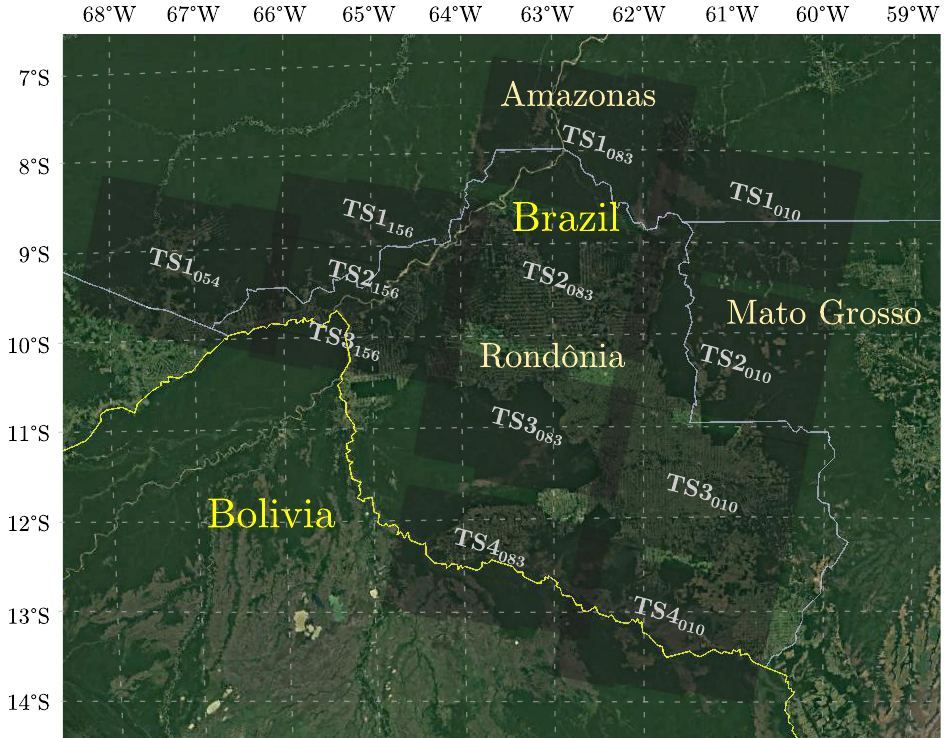
Figure 1. Study sites in the Amazon Forest comprising the Brazilian states of Rondônia, Amazonas, and Mato Grosso, as well as smaller regions in Bolivia. In total, 12 swaths were considered for mapping the Amazon Rainforest by processing S-1 interferometric STS, divided according to relative orbits 010, 054, 083, and 156. The considered footprints are superimposed on an aerial scene from Google